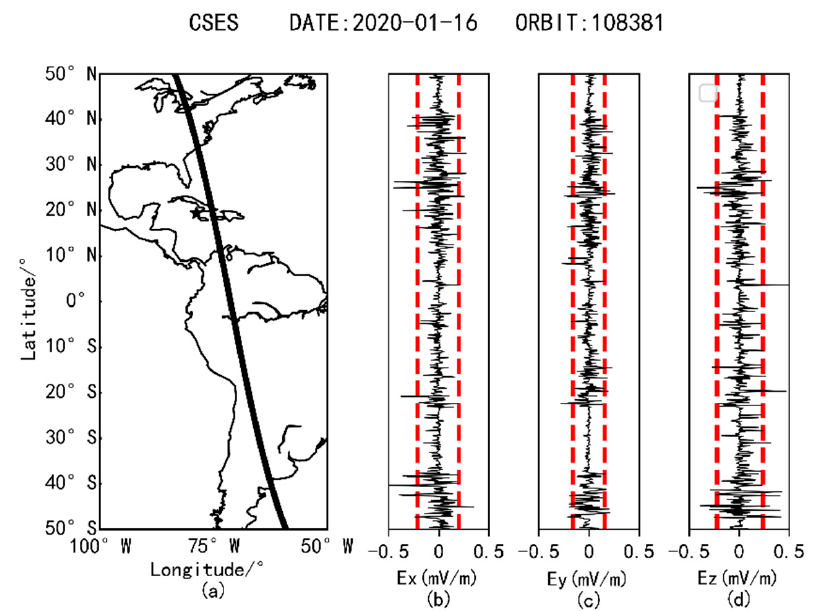
Figure 8. The 108,381 orbital position and disturbance waveform (In subfigure ( a ), the black star is the epicenter position and the black curve is the satellite flight path. Subfigure ( b – d ) depicts the small-scale residual disturbance waveforms after removing the electric field trend from the three components of the electric field ULF band.).